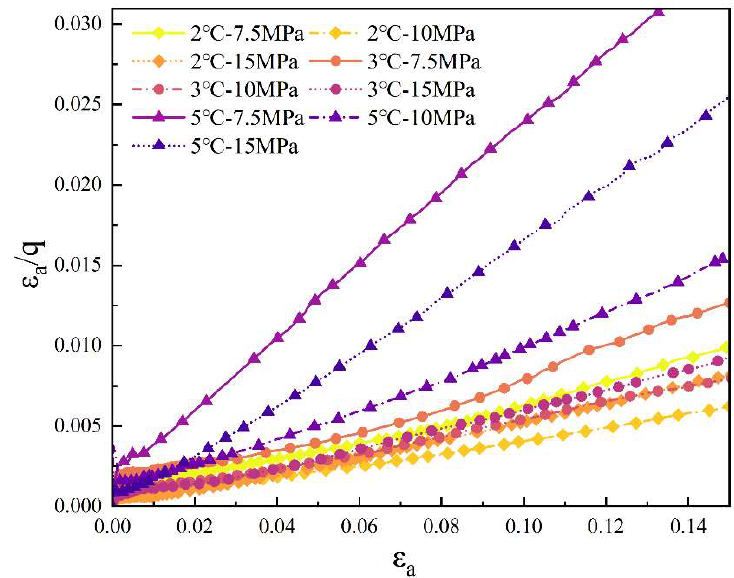
Figure 11. The relationship of ( ε a / q ) ∼ ε a .